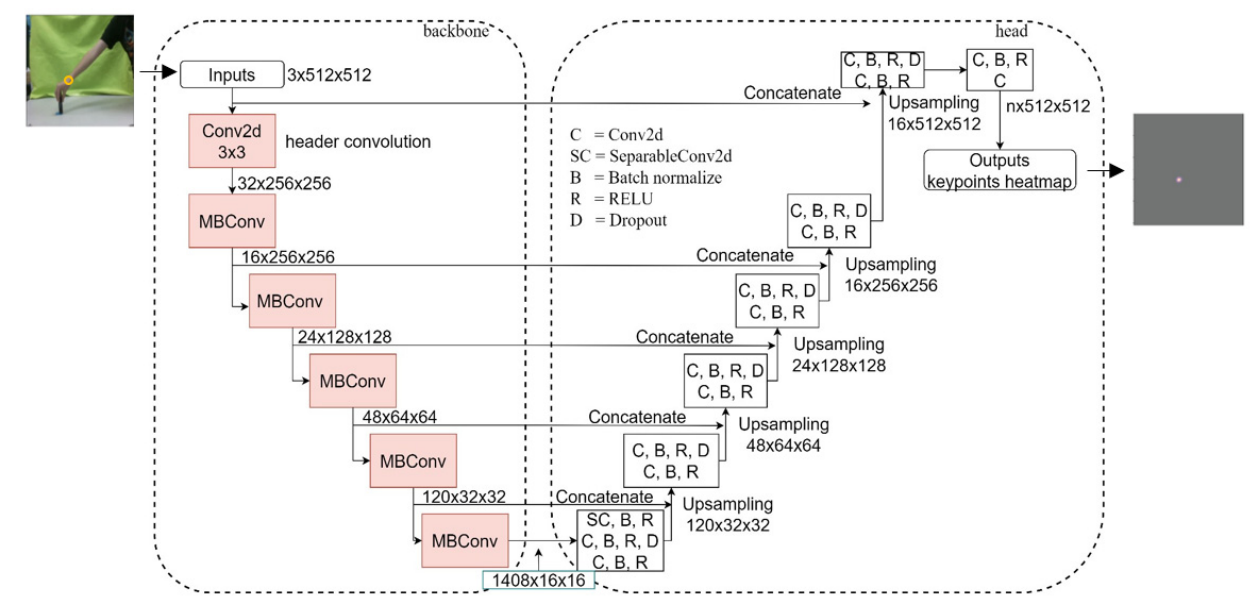
Figure 1. The keypoint prediction model.